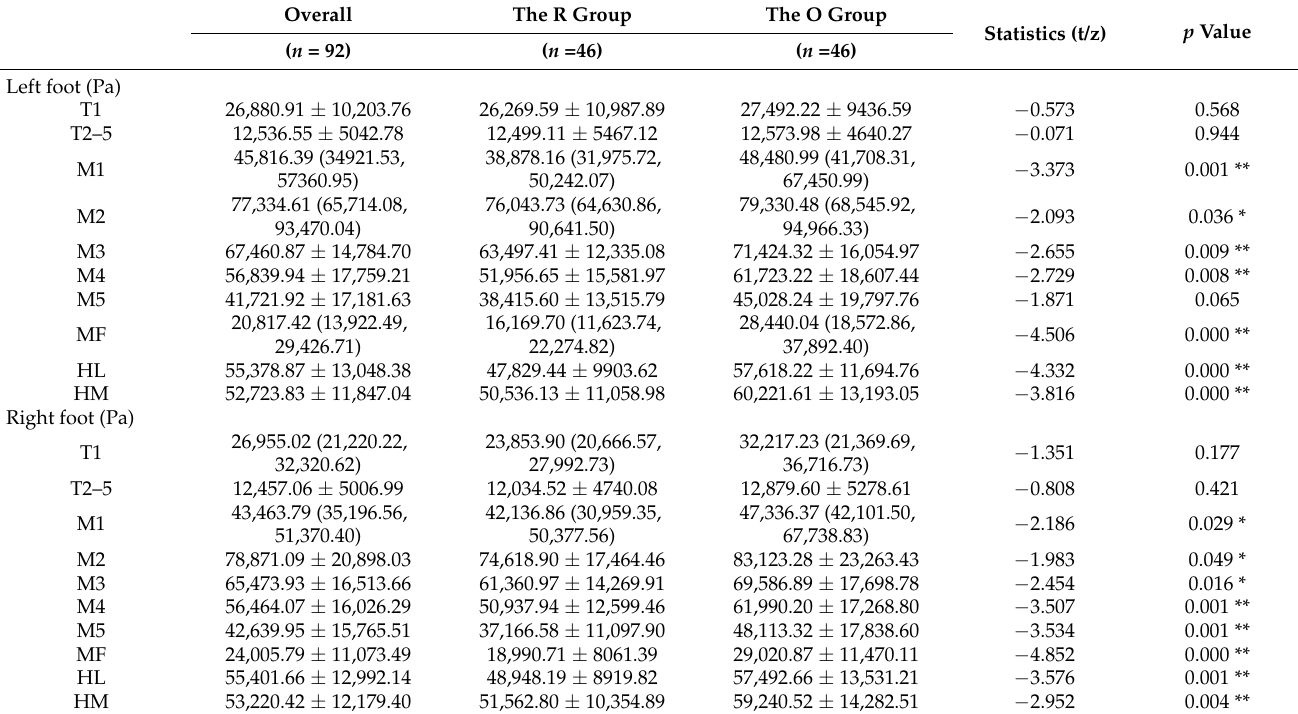
Table 6. The average pressure of the older women in the O and R